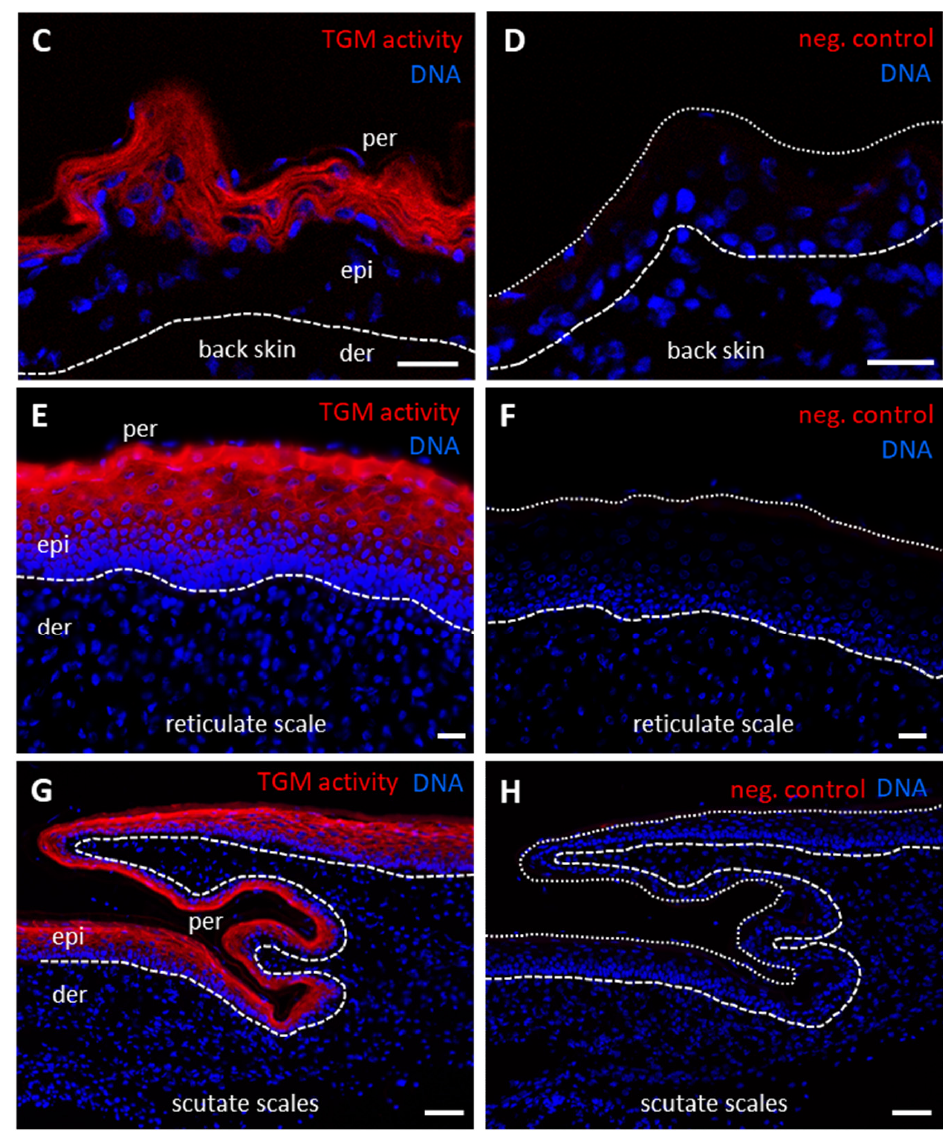
Figure 4. In situ labeling of transglutaminase (TGM) activity in chicken skin models and chicken skin. Skin models consisting of keratinocytes and fibroblasts isolated from chicks and cultured in vitro ( A , B ) and back skin ( C , D ), reticulate scales ( E , F ) and scutate scales ( G , H ) from chicken embryos (Hamburger and Hamilton stage 44) were cryosectioned and incubated with Alexa-fluor 555-cadaverine (red) in buffer containing either calcium ( A , C , E , G ) or, as negative (neg.) control, EDTA ( B , D , F , H ). Nuclear DNA was labeled with Hoechst 33258 (blue). The images were recorded with an Olympus BX63 microscope ( A , B , E – H ) and a Zeiss 980 confocal laser scanning microscope ( C , D ). The brightness of the images in panels ( A – D ) was uniformly increased by 20%. White dashed lines indicate lower border of the epidermis ( A – H ) and white dotted lines indicate the upper border of the epidermis in images of negative control samples ( B , D , F , H ). Scale bars = 20 µ m ( A – F ), 50 µ m ( G , H ). der, dermis; epi, epidermis; per, periderm. TGM activity was also detected in a membrane-associated pattern in the suprabasal layers of the chicken esophageal epithelium, whereas no activity was present in the three most basal layers and in the mesenchymal compartments of the esophagus (Figure 5A,B). This pattern was similar to the patterns of TGM activity in the esophagus of the zebra finch (Figure 5C,D) and the mouse (Figure